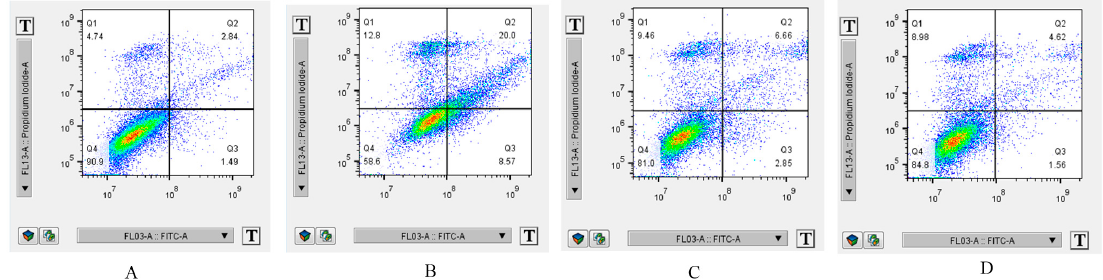
Figure 4. MDA-MB-231 cell apoptosis. A : DMSO; B : CA4 (1 µM); C : 7j (1 µM); D : 7j (0.1 µM).